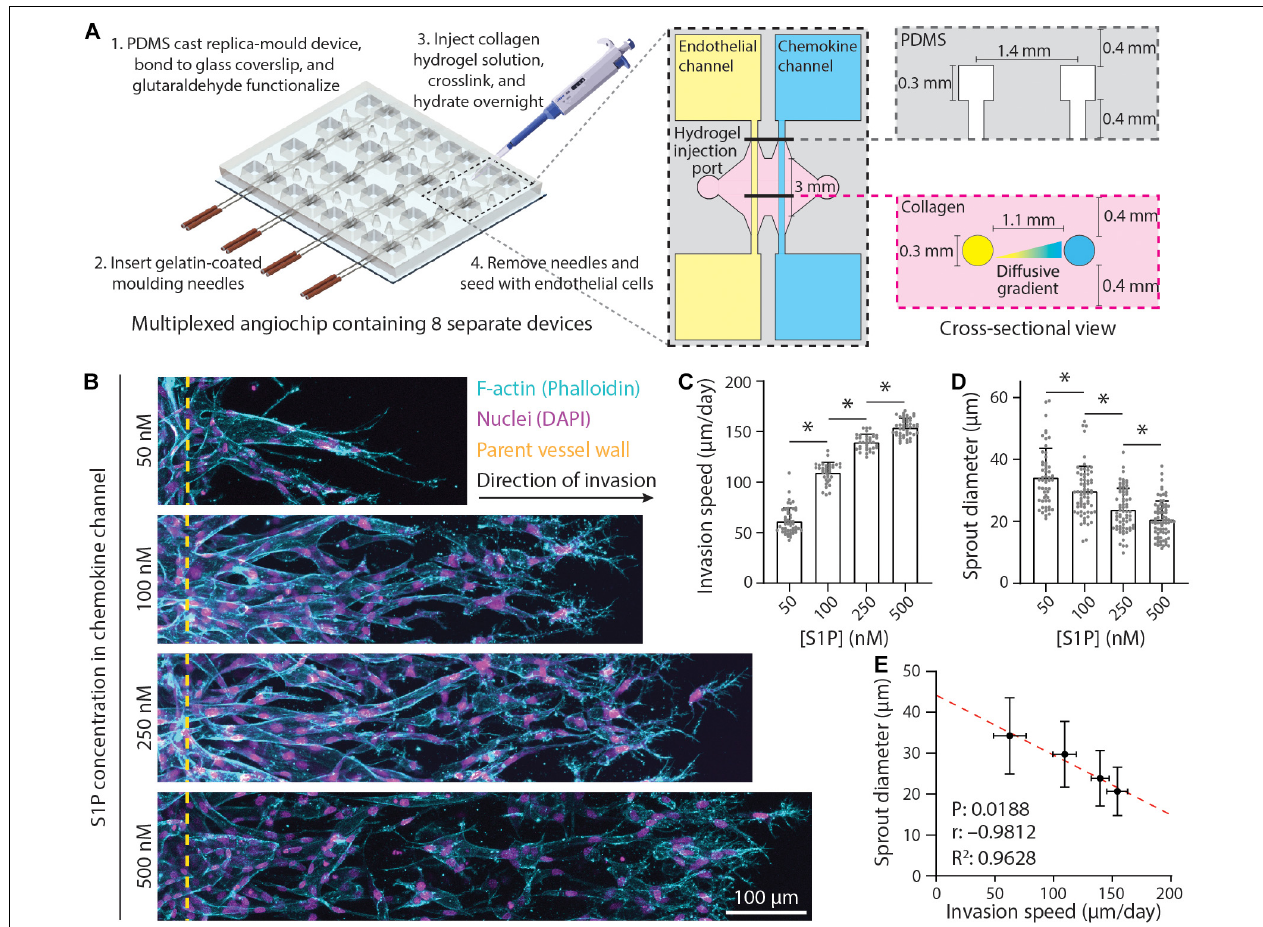
FIGURE 1 | Endothelial sprout invasion speed is anti-correlated with sprout diameter. (A) Schematic overview of multiplexed angiogenesis-on-a-chip platform. Polydimethylsiloxane (PDMS) replica casts are generated from 3D printed molds and are composed of a 2 × 4 array of single devices. These PDMS molds are bonded to glass coverslips and functionalized with glutaraldehyde (Step 1). Gelatin-coated needles are then inserted into the device (Step 2). Type 1 collagen hydrogel precursor solution is injected into each device, allowed to cross-link around the needles, and hydrated overnight (Step 3). Needle removal generates 3D channels fully embedded within user-defined hydrogel (Step 4). Each device is composed of two parallel channels: (1) an endothelial channel seeded with endothelial cells (ECs) to serve as the parent vessel from which angiogenic sprouting is induced and (2) a chemokine channel to which pro-angiogenic factors [e.g., sphingosine 1-phosphate (S1P)] are added to generate diffusive gradients that promote EC activation and invasion across a user-defined 3D extracellular matrix (e.g., collagen hydrogel). (B) Representative images (max intensity projections) of invading ECs in response to varying S1P. All conditions were cultured for 5 days with indicated S1P dose in endothelial cell growth medium 2 [EGM2; supplemented with 25 ng ml − 1 phorbol 12-myristate 13-acetate (PMA)] added to the chemokine channel within 3 mg ml − 1 collagen hydrogels. F -actin (cyan), nuclei (magenta), and yellow dashed lines indicate parent vessel edge. (C,D) Quantifications of invasion speed and sprout diameter as a function of S1P. For invasion speed: n ≥ 36 per condition and for sprout diameter: n ≥ 55 per condition. (E) Relationship between invasion speed and sprout diameter, with red dashed line indicating a linear regression and statistical analysis performed by Pearson’s correlation. Sample size for each mean was taken from panels (C,D) . All data presented as mean ± SD; ∗ indicates a statistically significant comparison with P < 0.05 (one-way analysis of